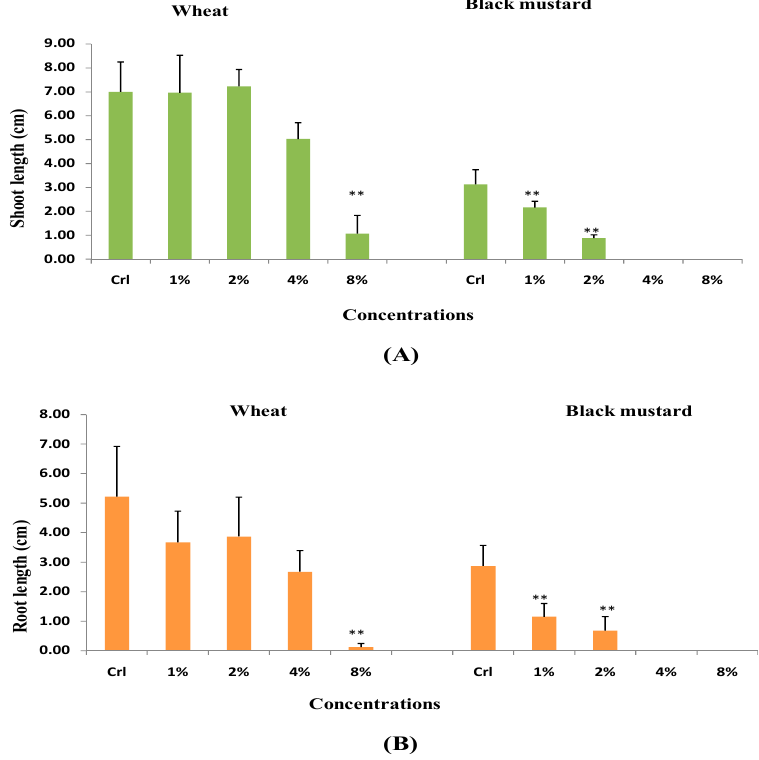
Figure 3. Effect of the aqueous extract of H. persicum on shoot length ( A ) and root length ( B ) of wheat and black mustard seedlings. ** = highly significant, Crl = Control.